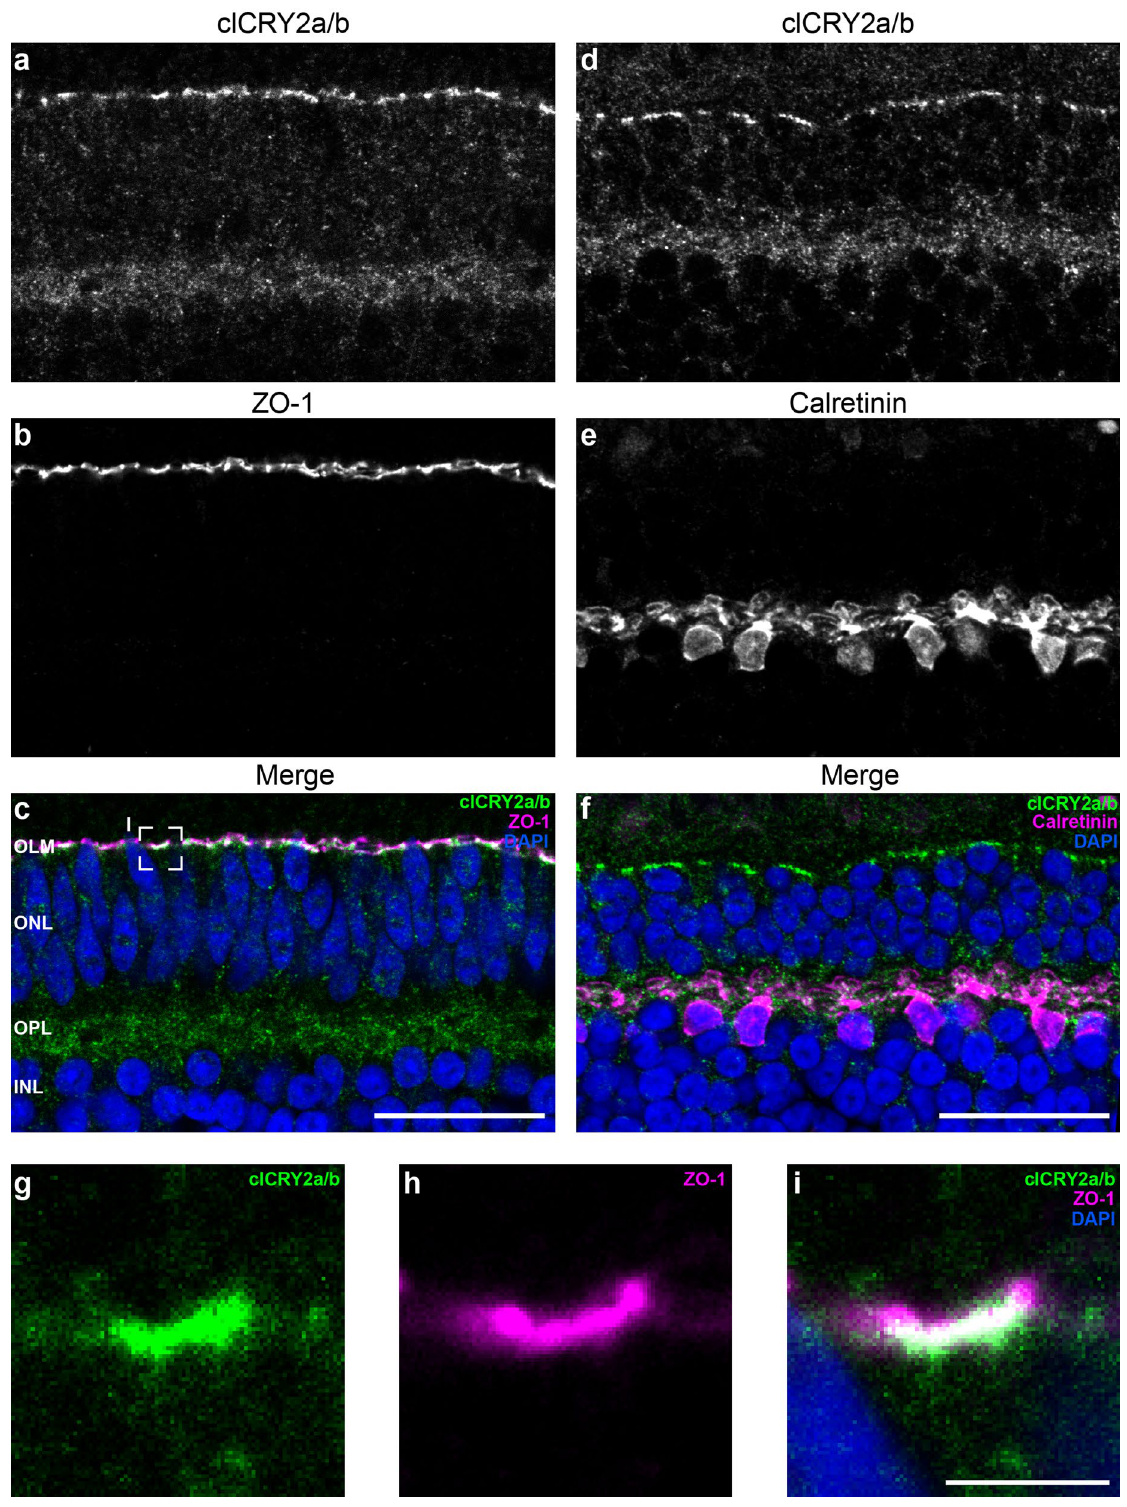
Figure 4. clCRY2a/b is enriched in the OLM and OPL at midday. ( a – i ) Double immunofluorescence staining reveals clCRY2a/b is expressed in the OLM ( a – c ) and OPL ( d – f ) at 12:00 CET. ( e , f ) Staining with Calretinin shows that clCRY2a/b is present within the cytosol of horizontal cells. ( g – i ) In the OLM, clCRY2a/b staining strongly overlaps with the scaffolding protein zonula occludens-1 (ZO-1), an adherens junction marker. OLM: outer limiting membrane, ONL: outer nuclear layer, OPL: outer plexiform layer, INL: inner nuclear layer. Scale bars: ( a – f ) 25 μm, ( g – i ) 3 μm. See Fig. S3 for staining